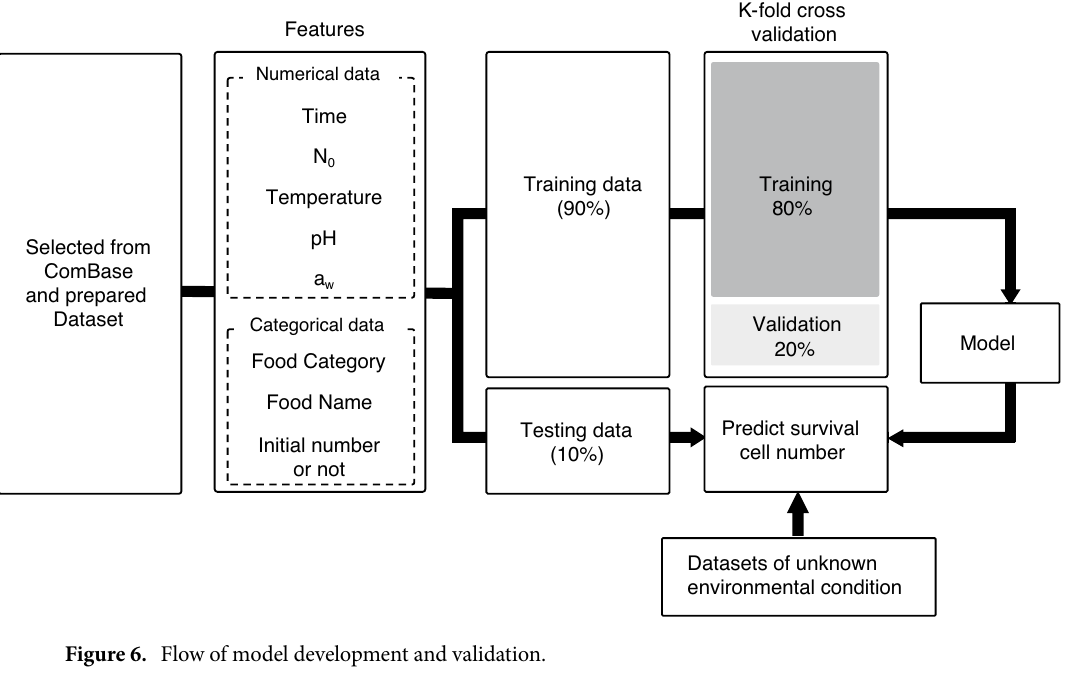
Figure 6. Flow of model development and